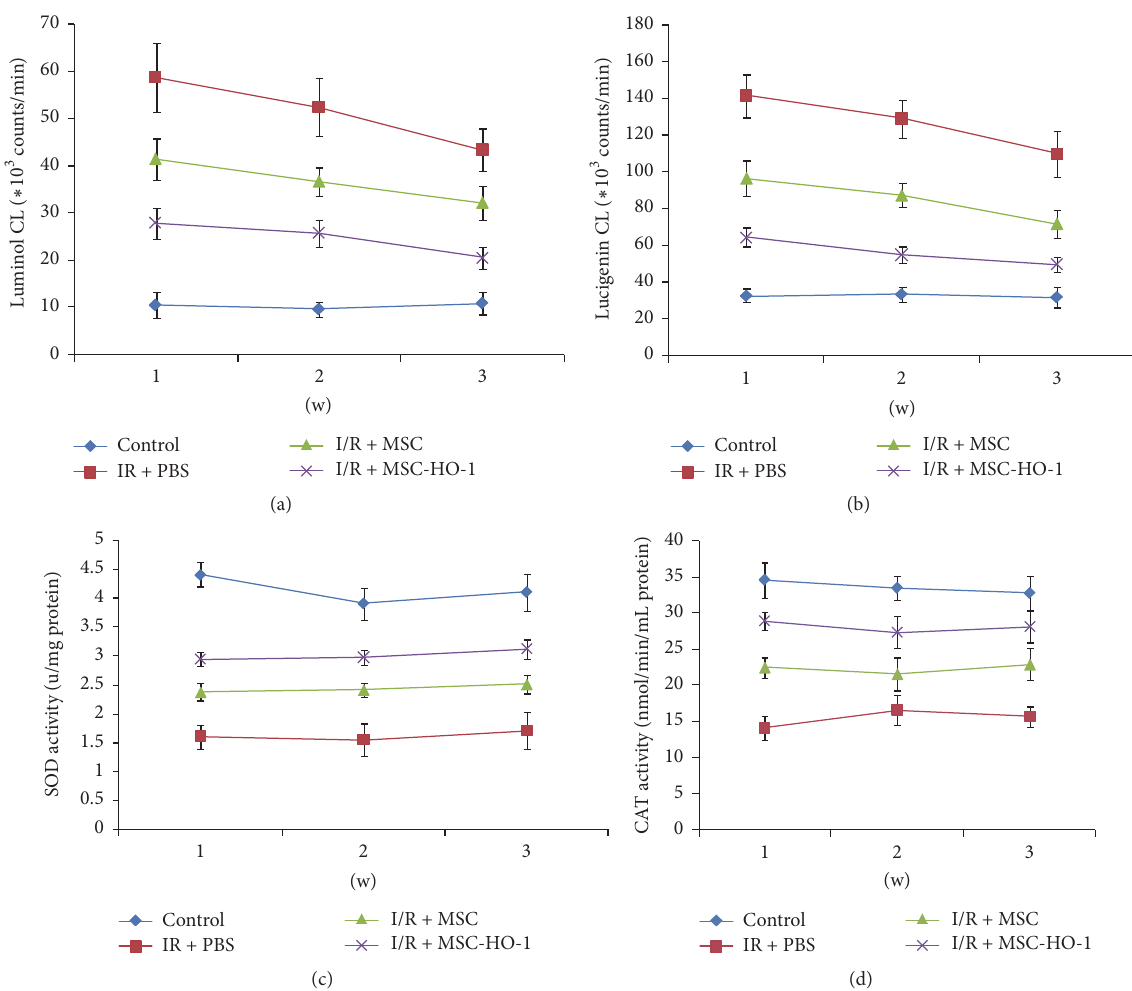
Figure 7: Effects of MSC-HO-1 transplantation on retinal ROS and antioxidase activity after I/R injury. (a) Luminol- and (b) lucigenin- enhanced chemiluminescence and the activity of (c) SOD and (d) CAT enzymes in retinas of the control, I/R + PBS, I/R + MSC, or I/R + MSC-HO-1 group were investigated at weeks 1, 2, and 3, respectively ( 𝑛 = 5 ).